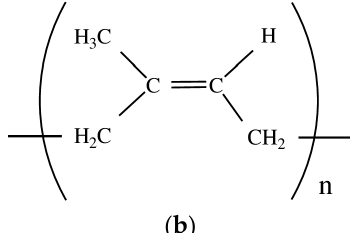
Figure 1. Structural formulas of LDPE ( a ) and natural rubber ( b ).